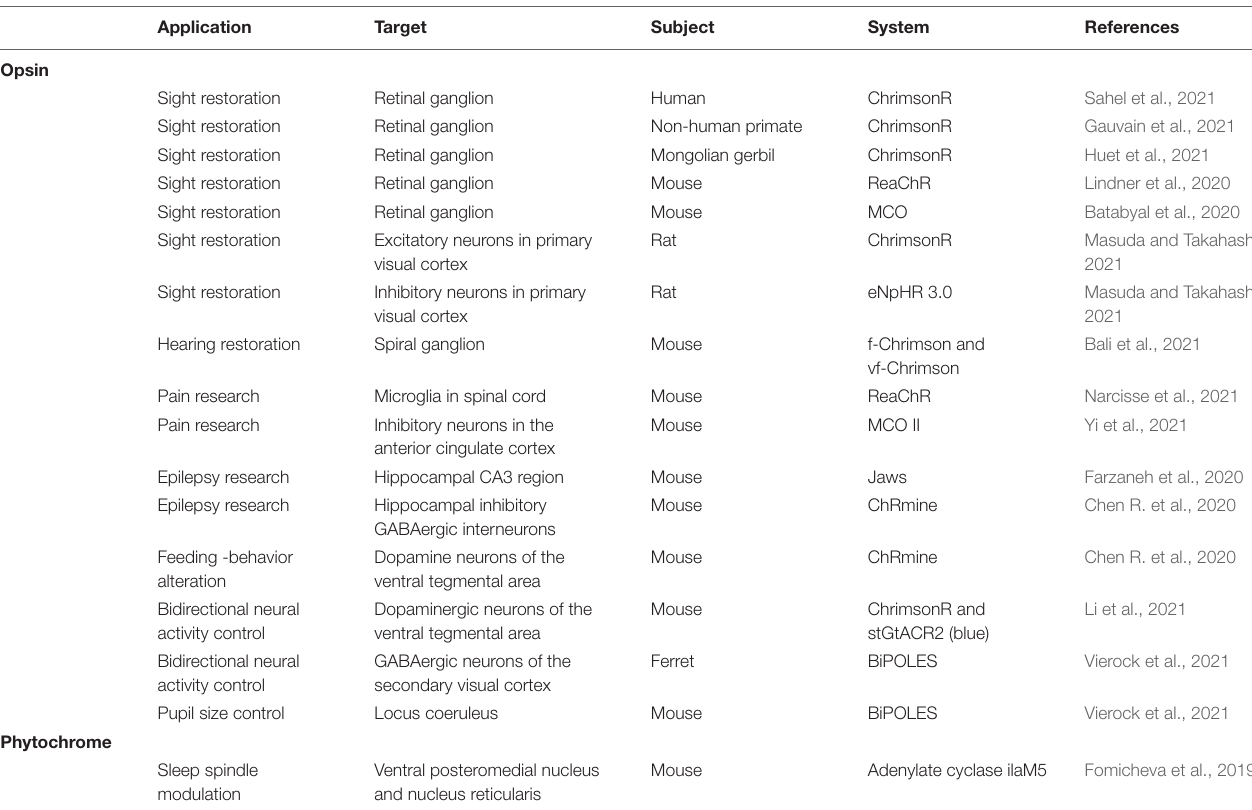
TABLE 1 | Red light optogenetics in neuroscientific animal studies.